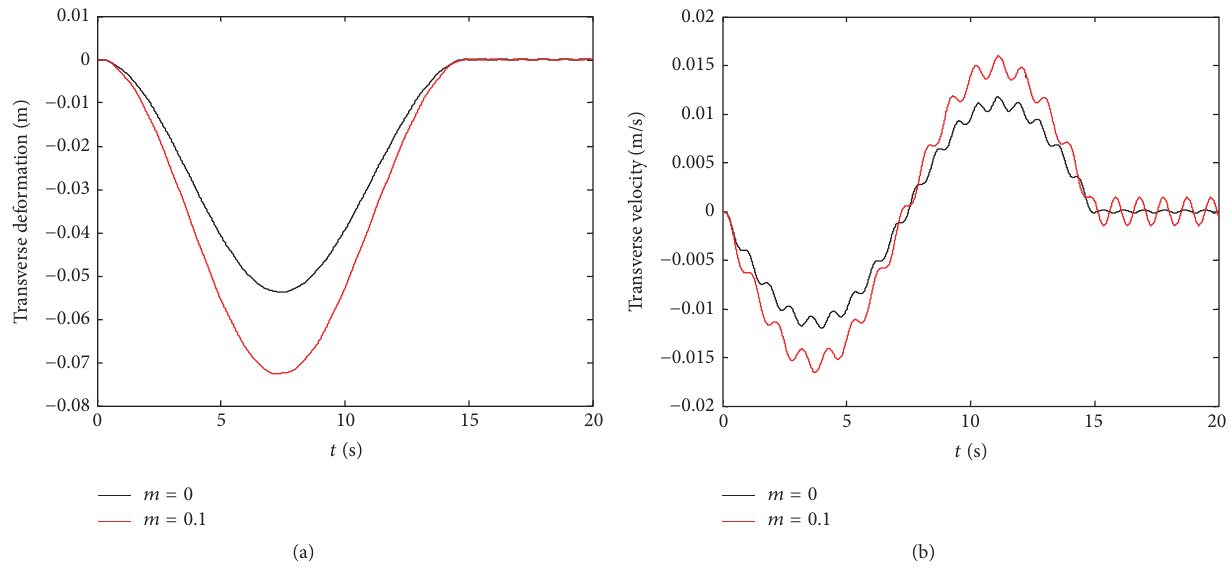
Figure 4: Effect of the concentrated mass on the response when flexible beam is subjected to acceleration process, (a) deformation and (b)